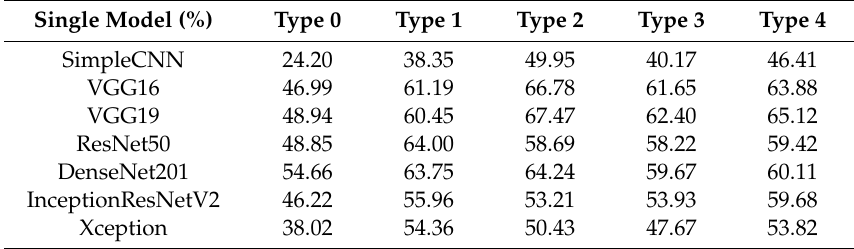
Table 9. Classification performance of the CNNs with data augmentation under transfer learning (5 classes).